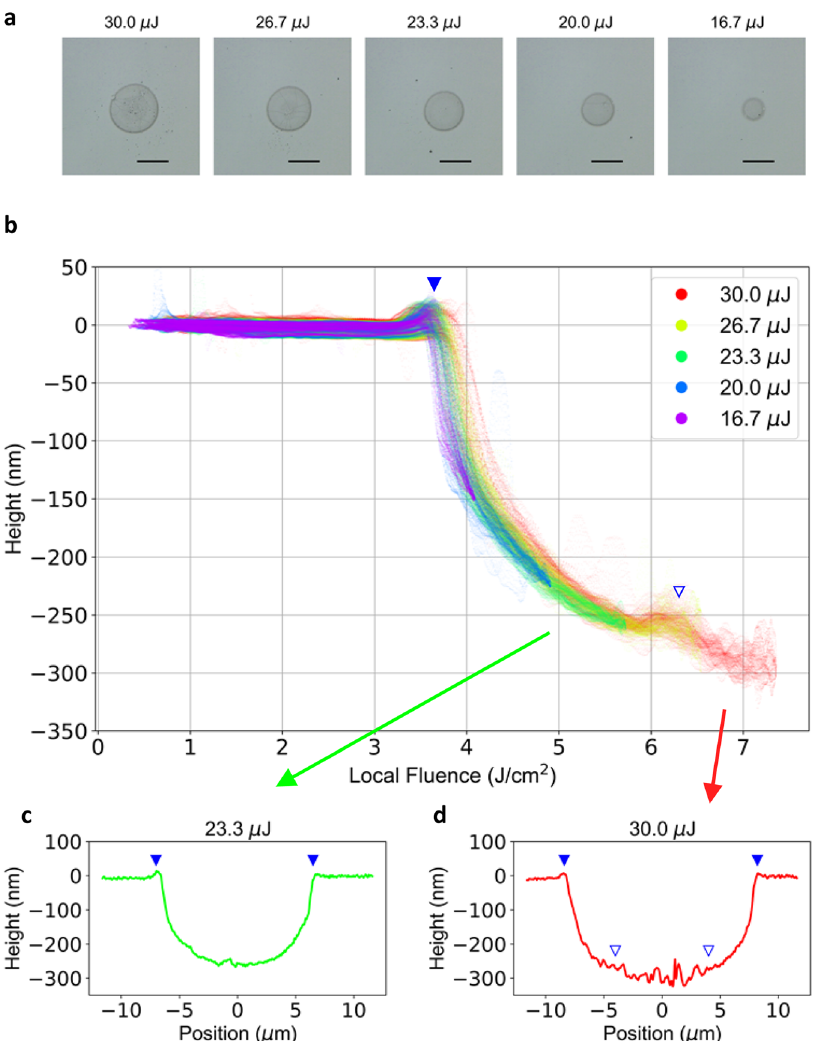
Fig. 4 Properties revealed from a fl uence map. a Craters ablated on the surface of sapphire by a 1028 nm, 190 fs laser pulse at fi ve different pulse energies. The scale bar corresponds to 10 μ m. b The corresponding fl uence maps for the craters of a . Two thresholds can be discerned where the crater morphology undergoes an abrupt change, denoted by the fi lled and open triangles. c , d Representative spatial line pro fi les for two craters above ( d ) and below ( c ) the second threshold denoted by the open triangle. The approximate spatial location where the local fl uence becomes higher than the two corresponding thresholds highlighted in b are